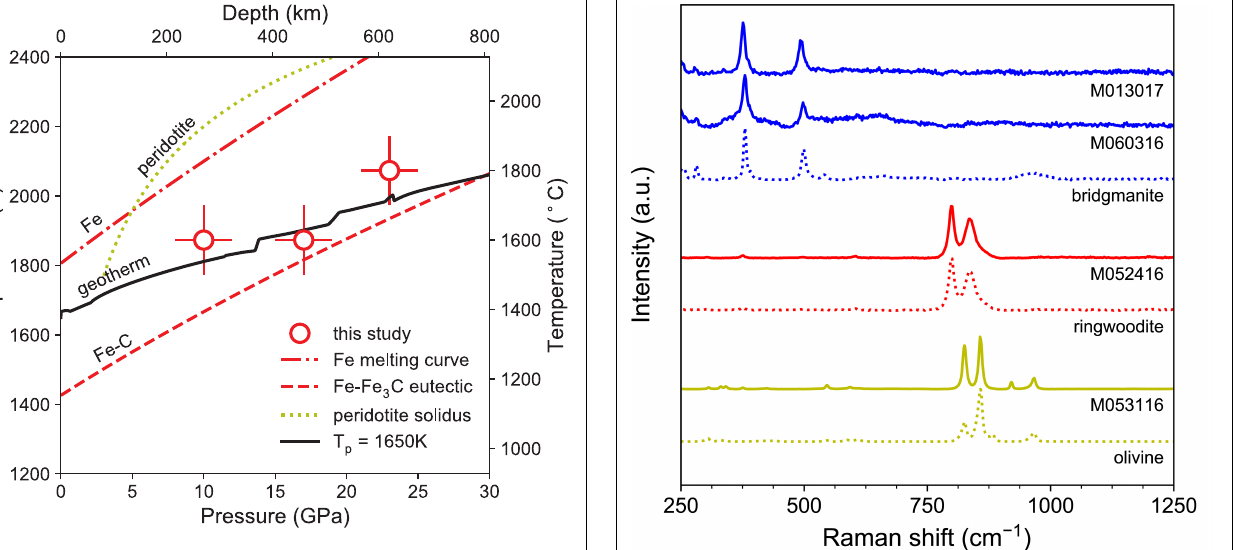
FIGURE 4 | Raman spectra of silicate phases in experimental products. Reference spectra (dashed) are plotted for